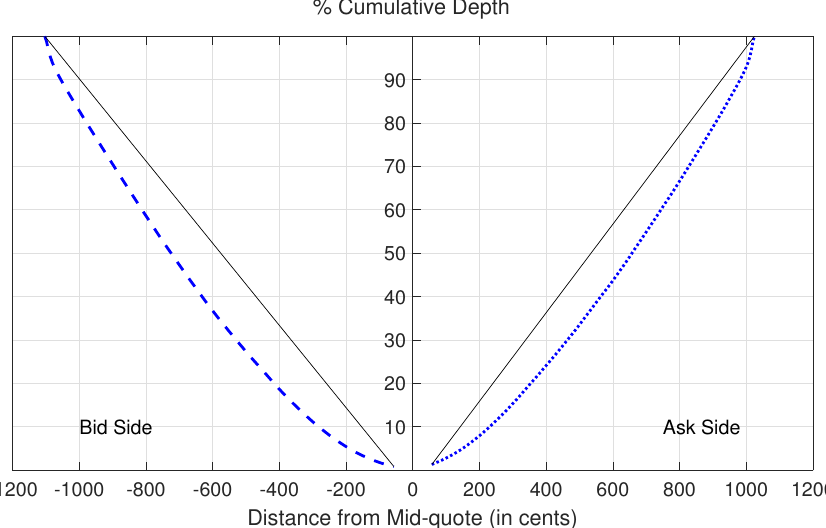
Figure 2. Percentage share of cumulative depth up to the 150th price level. The figure shows the percent of cumulative depth ( y -axis) by the distance from the mid-quote in cents ( x -axis). Average cumulative depths and price distances are computed from one-minute snapshots of BTC-e limit order book for the period from 7 December 2013 to 24 September